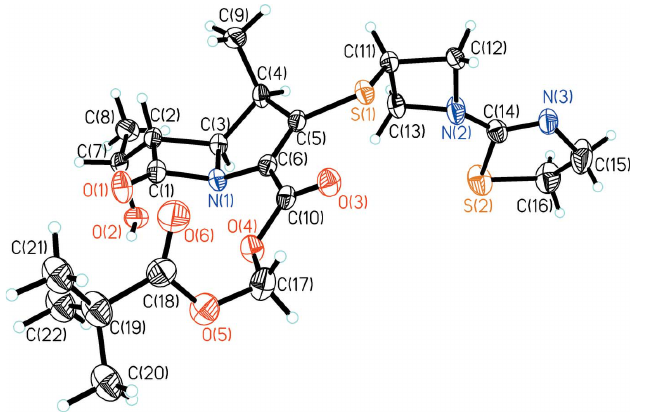
Figure 1 The molecular structure of the title compound, showing the atom labelling and 30% probability displacement ellipsoids.